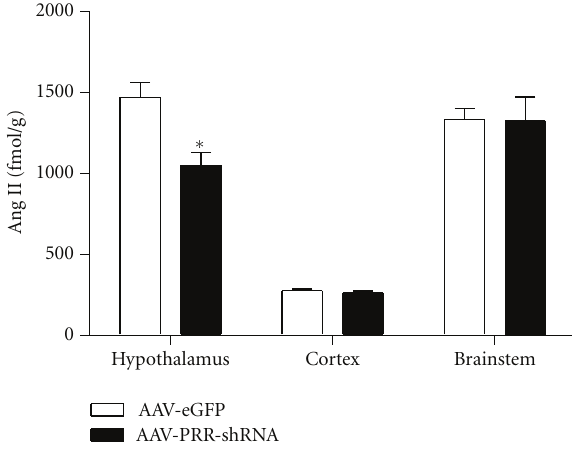
Figure 2: ICV delivery of (pro)renin receptor shRNA reduces brain Ang II level in the hypothalamus. The human renin and AGT double transgenic mice were ICV injected with AAV-PRR short hairpin RNA (AAV-PRR-shRNA, 3 . 5 × 10 11 Vg/100nl) or control virus. Two weeks after virus injection, brain tissues were harvested for analysis of Ang II levels in the hypothalamus, cortex, and brainstem. ( n = 6/group). ∗ P < 0 . 05 versus AAV-enhanced green fluorescent protein (AAV-eGFP)